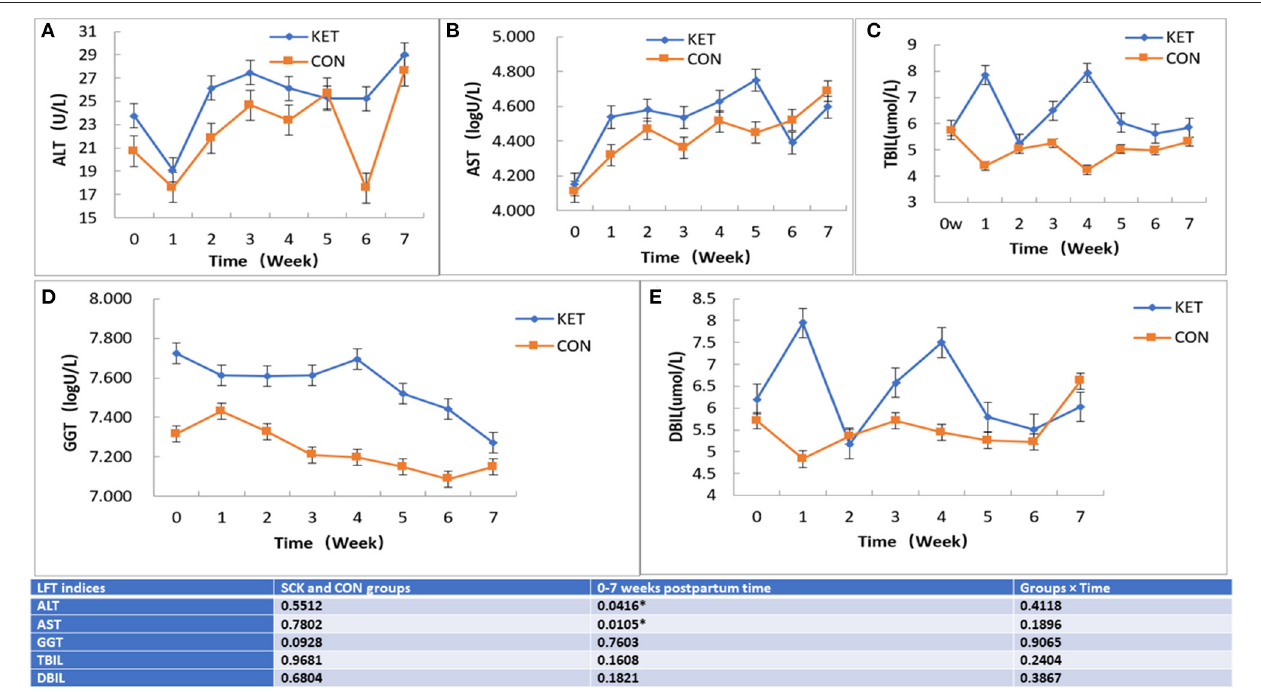
FIGURE 3 | The effect on ALT, AST TBIL, GGT, and DBIL (A-E) LFT indices in SCK and CON healthy dairy cows monitored weekly eight times. (A) Effects of ALT-LFT in SCK and CON healthy dairy cows monitored weekly eight times. (B) Effects of AST-LFT in SCK and CON healthy dairy cows monitored weekly eight times. (C) Effects of GGT-LFT in SCK and CON healthy dairy cows monitored weekly eight times. (D) Effects of TBIL-LFT in SCK and CON healthy dairy cows monitored weekly eight times. (E) Effects of DBIL-LFT in SCK and CON healthy dairy cows monitored weekly eight times. *Denotes the difference is significant at p <